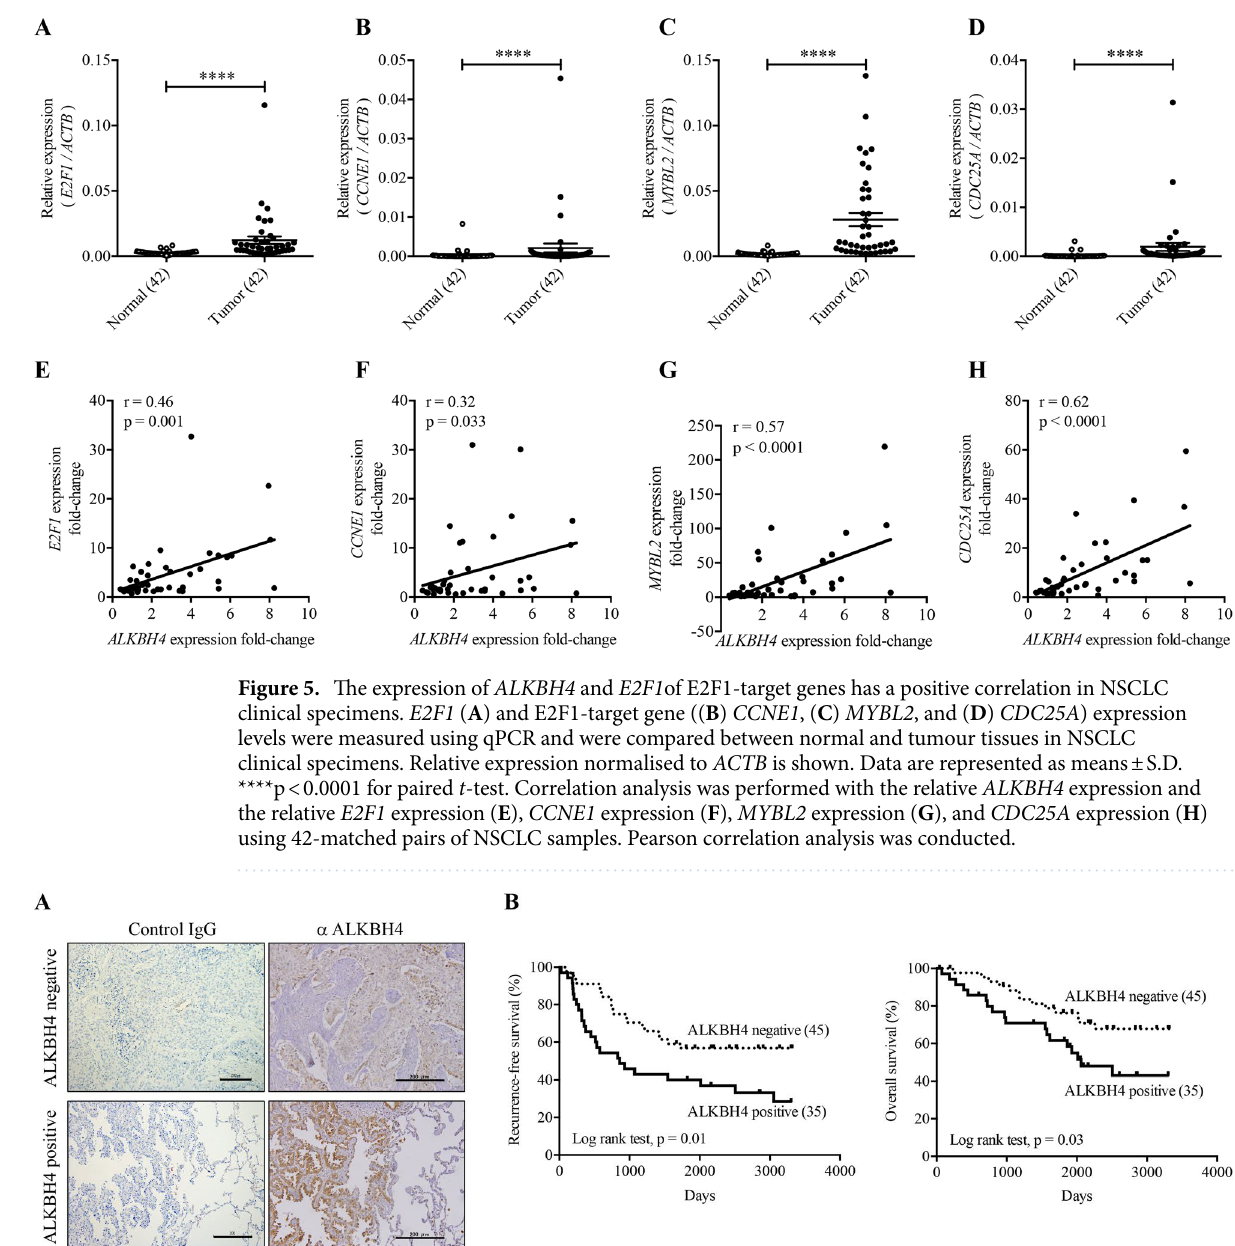
Figure 6. Association of ALKBH4 expression levels with recurrence-free survival and overall survival. ( A ) Expression of ALKBH4 in NSCLC specimens was examined using immunohistochemical staining. Representative results are shown. Black scale bars, 200 μm. Association of ALKBH4 expression levels with recurrence-free survival ( B ) and overall survival ( C ). NSCLC tissue specimens stained with anti-ALKBH4 were divided into two groups, according to ALKBH4 expression: negative (45 samples) and positive (35 samples). Data was statistically analysed using Log-rank